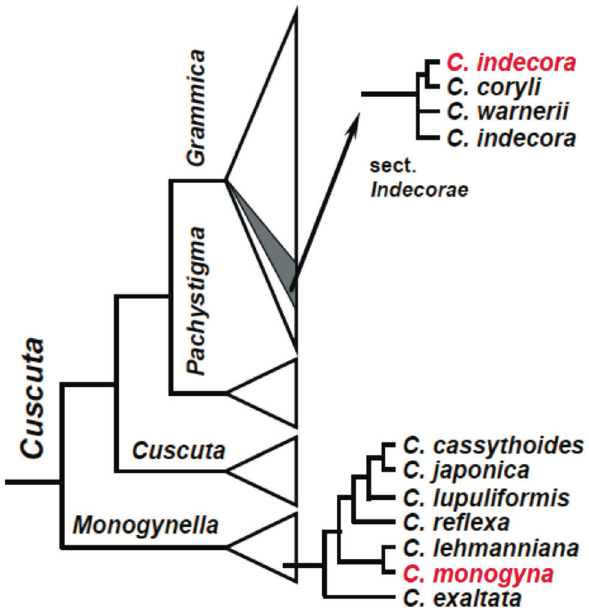
Figure 1 - Schematic overview of the phylogenetic relationships in Cus- cuta derived from sequence data from plastid ( trnL-F , rbcL ) and nuclear (nrITS, nrLSU) sources and analyzed with a range of analytical methods (modifiedfromCostea etal. ,2015).Infragenericclassificationisprovided above branches on the left, and more detailed relationships among species of Cuscuta sect. Indecorae and Cuscuta subgenus Monogynella are shown on the right (Stefanovi (cid:2) et al. , 2007; García et al. , 2014). Species of partic- ular interest for this study are highlighted in red. Note that C. indecora is not monophyletic as currently